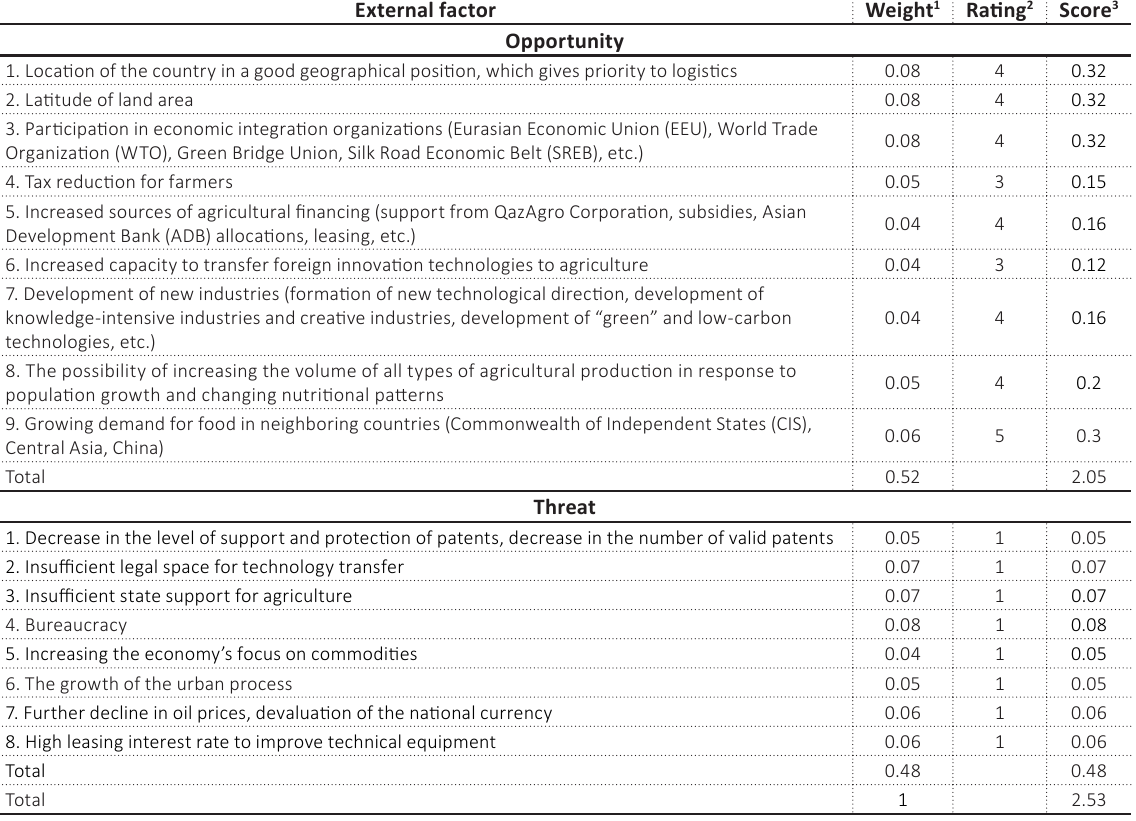
Table 1. EFE matrix of technology transfer to the agricultural sector of Kazakhstan